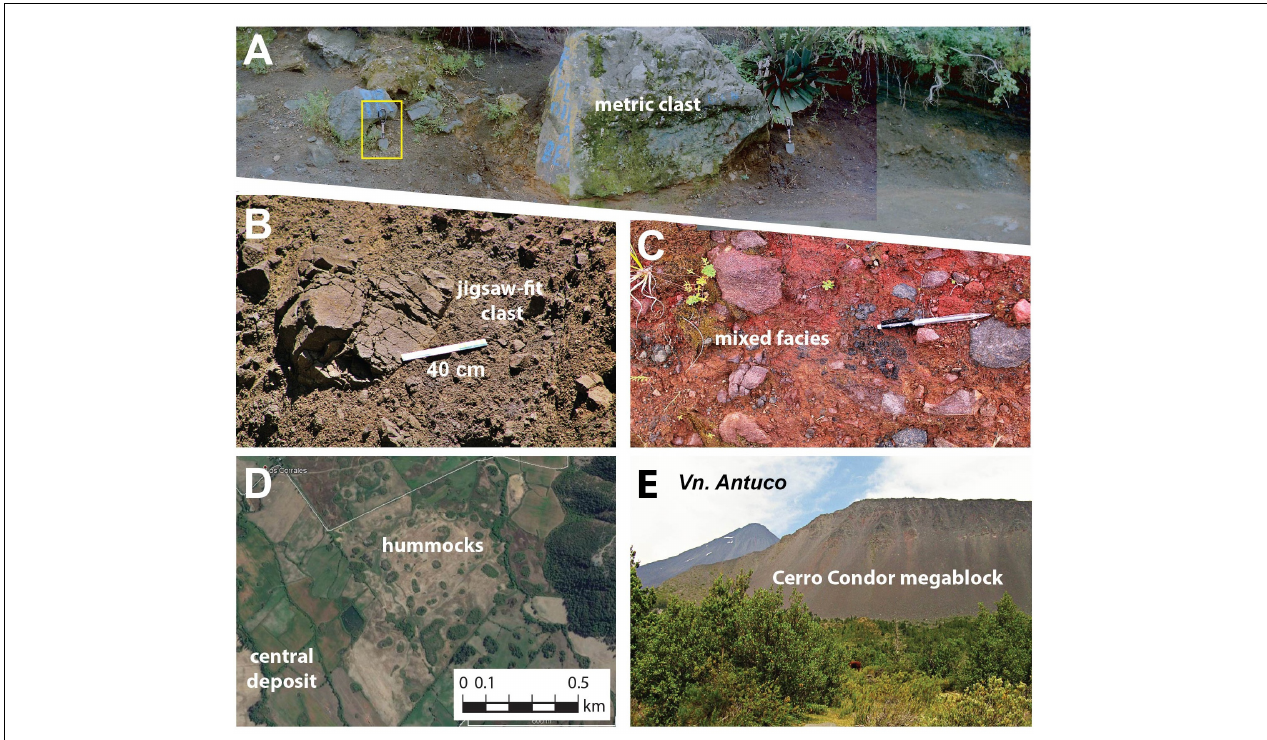
FIGURE 10 | Debris avalanche deposits (DADs). (A) VDAD from Pacaya (Guatemala) 1 kyr BP sector collapse, with the presence of metric clasts. Scale shovel indicated by the yellow square. (B) Jigsaw-fit clast and (C) matrix facies of the Antuco (Chile) VDAD. Hummocky surface left by the 90–20 kyr BP sector collapse of Planchón volcano (Chile). (E) Kilometric megablock (toreva) of the Antuco volcano sector collapse (Chile). Photo (A) was provided by Shigeru Kitamura and photos (B–E) by Jorge